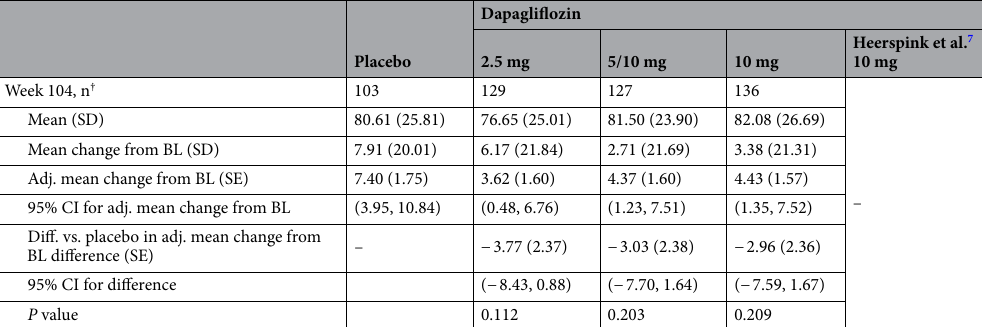
Table 1. Mean change in haematocrit, red blood cell count and reticulocytes from baseline in patients treated with 2.5, 5/10 and 10 mg dapagliflozin and insulin. Mixed model: change from baseline = baseline treatment week*treatment week*baseline. † Number of subjects in safety analysis dataset with non-missing baseline and Week t values. ‡ Values in Heerspink et al. 7 reported as × 10 3 c/µL. BL, baseline; CI, confidence interval; SD, standard deviation; SE, standard